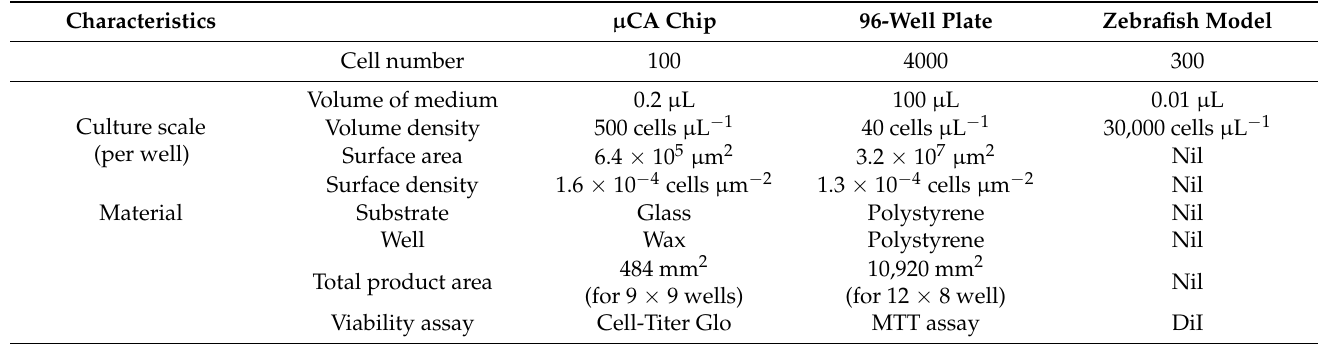
Table 1. Characteristics of the µ CA chip, 96-well plate, and zebrafish